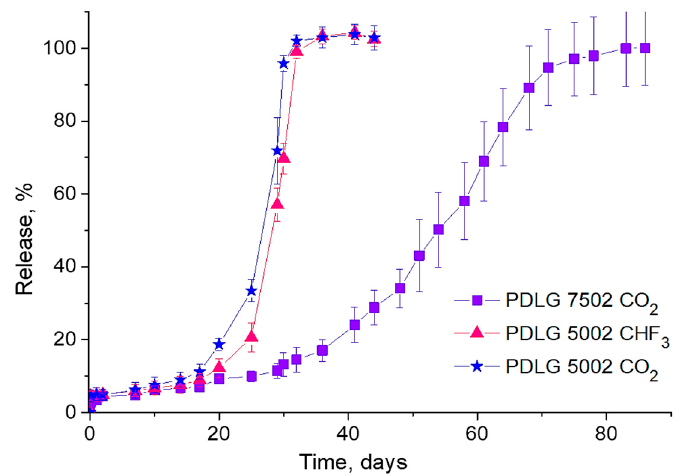
Figure 6. Kinetics of the LFX release into the PBS from polyester scaffolds made of various PDLG brands using different SCFs.